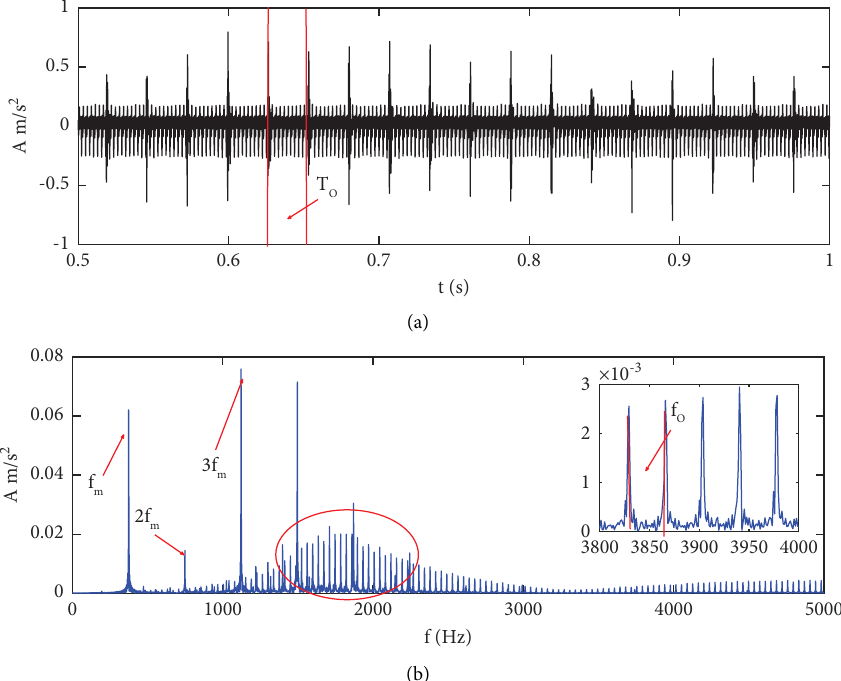
Figure 16: Te responses of the bearing node of the driven shaft with outer fault: (a) the time domain; (b) the frequency domain.